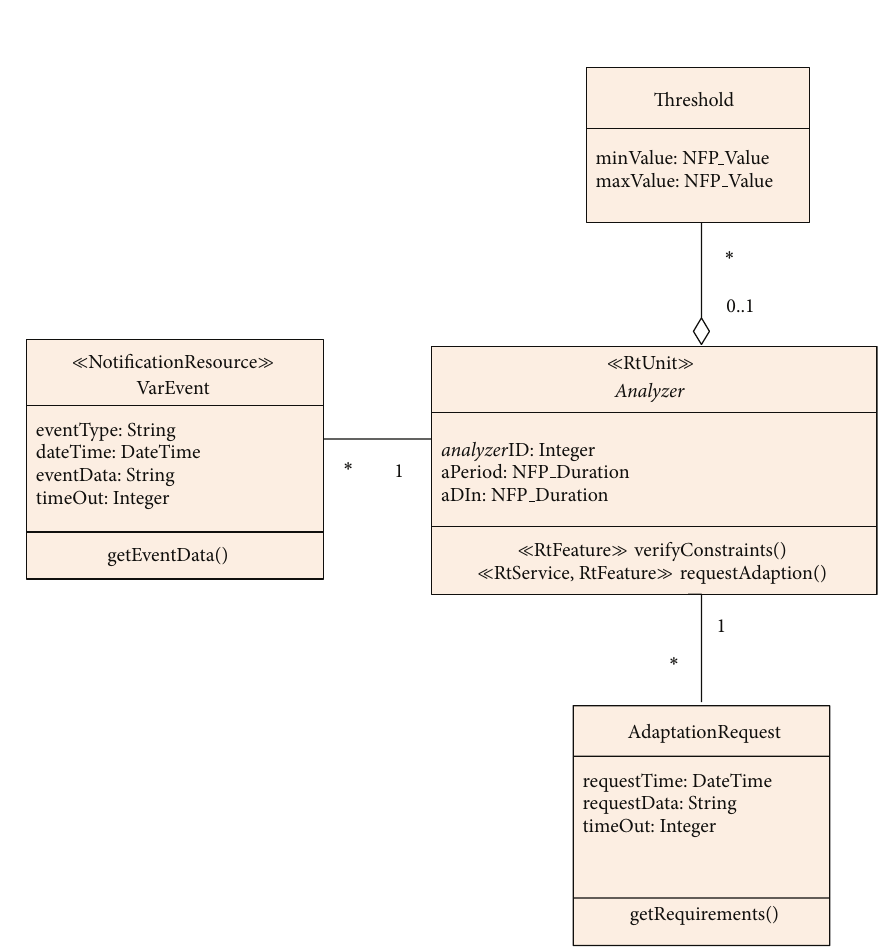
Figure 5: Structural view of the RTE Analyzer